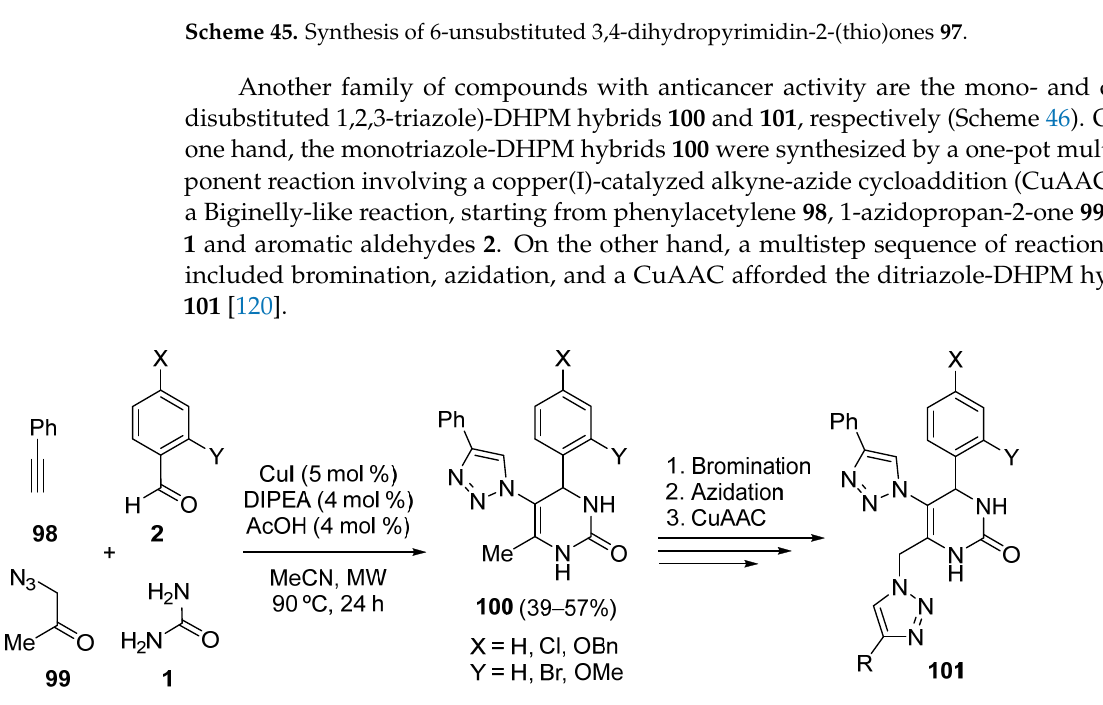
Scheme 46. Synthesis of mono- and di(1,4-disubstituted 1,2,3-triazole)-DHPM hybrids 100 and 101